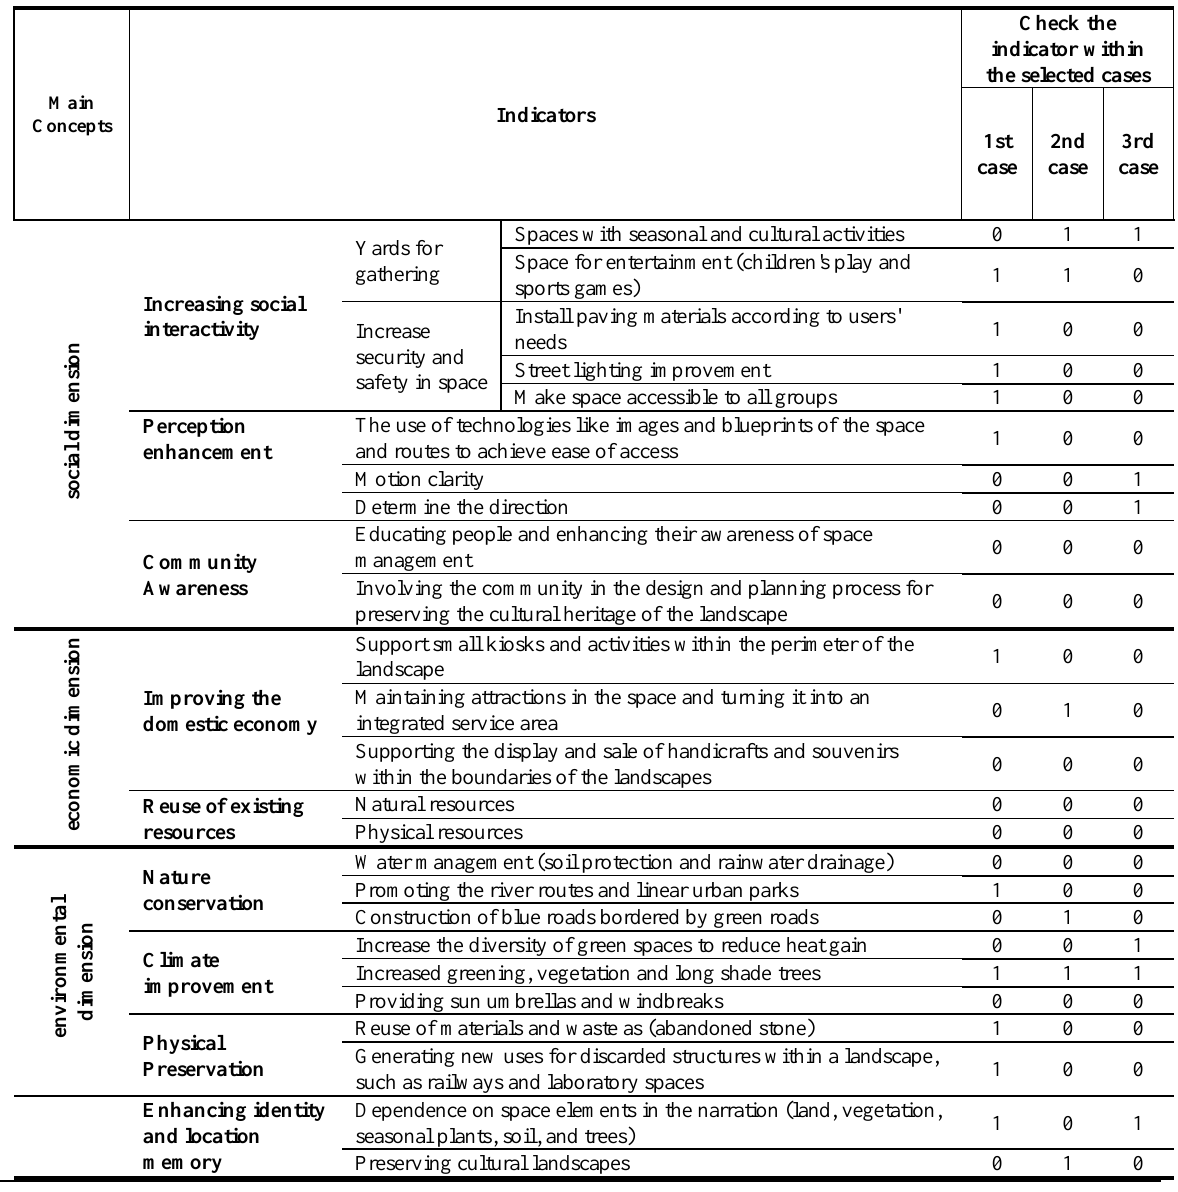
Table 5. The results of achieving the indicators of the dimensions of activating landscapes for the three cases, (prepared by the authors)